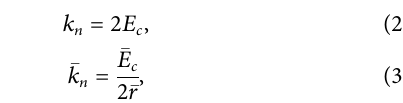
Frontiers in Earth Science |